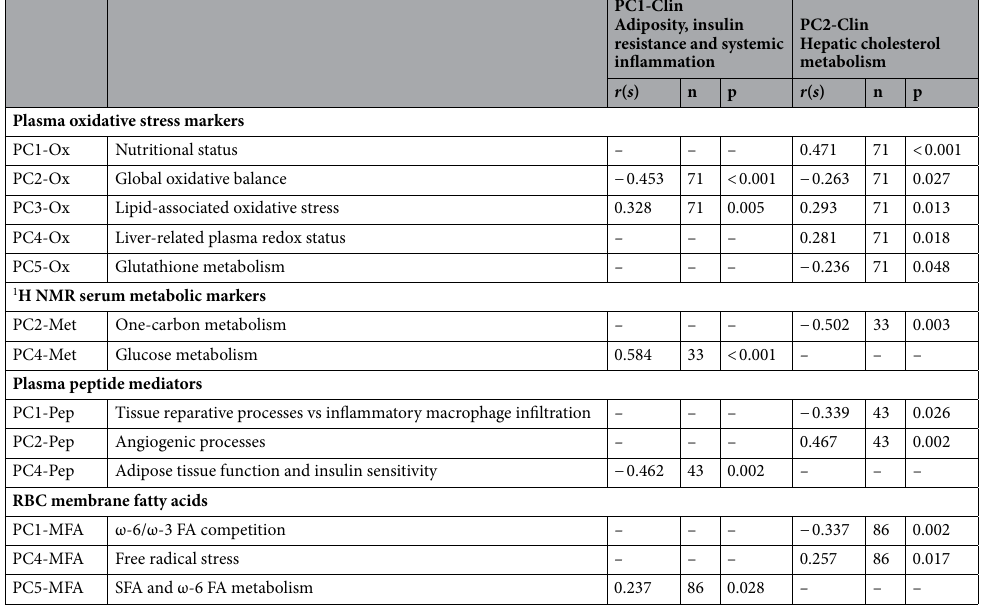
Table 2. Bivariate correlation analysis of PC1-Clin and PC2-Clin versus the PCs of the other datasets. Only significant correlations are